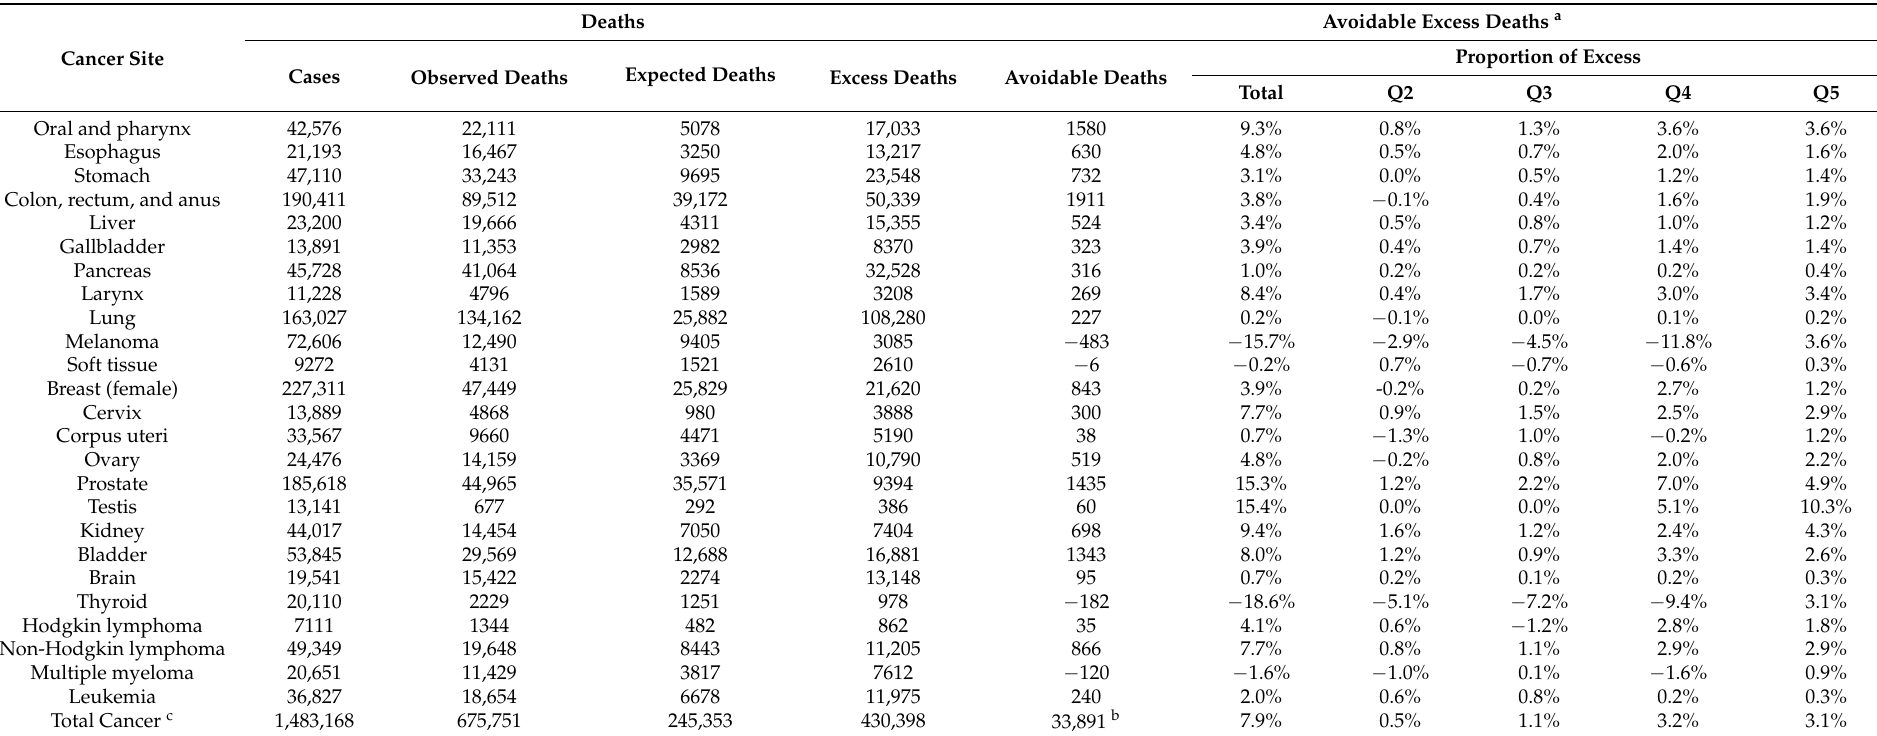
Table 3. Estimated number of deaths and excess deaths within five years of diagnosis for cancer patients diagnosed in 2013–2017 and estimated number of avoidable excess deaths caused by socioeconomic differences in the study